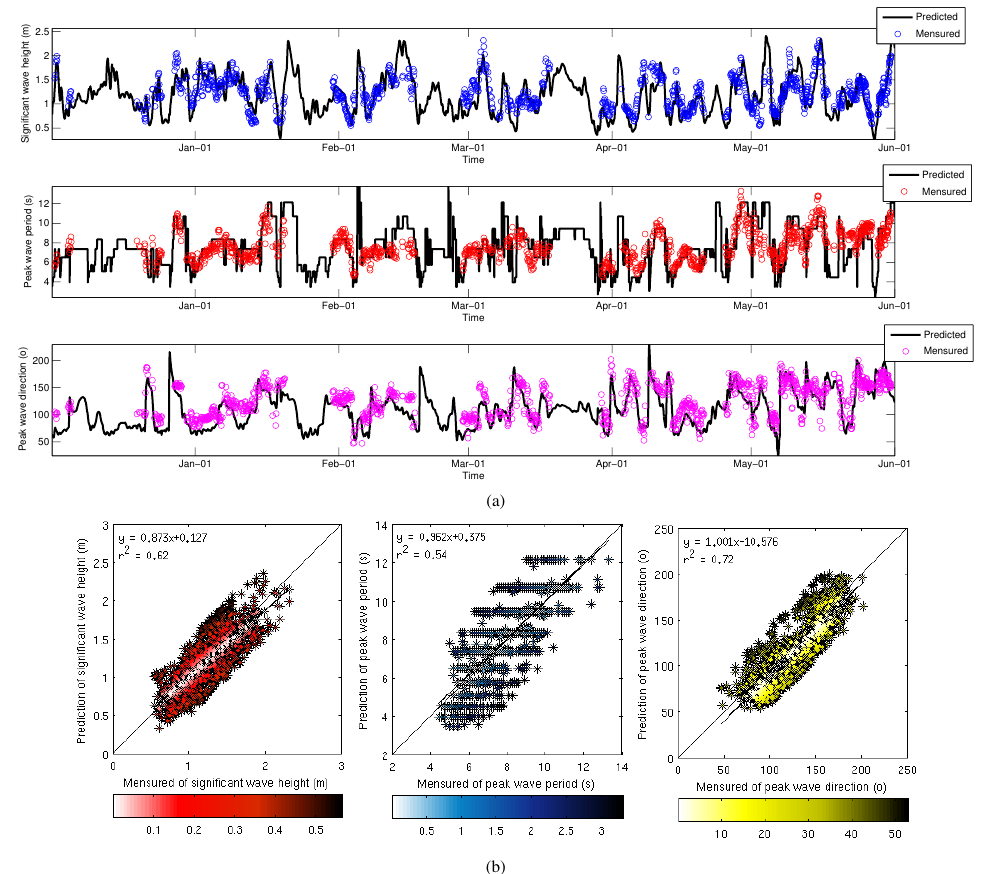
Figure 2. Validation of the SWAN wave model with the directional buoy data. (a) The SWAN predictions are shown in continuous lines and the buoy data are in circles. (b) Scatterplot of the linear correlation; the colors of the dots represent the distance from the regression line.